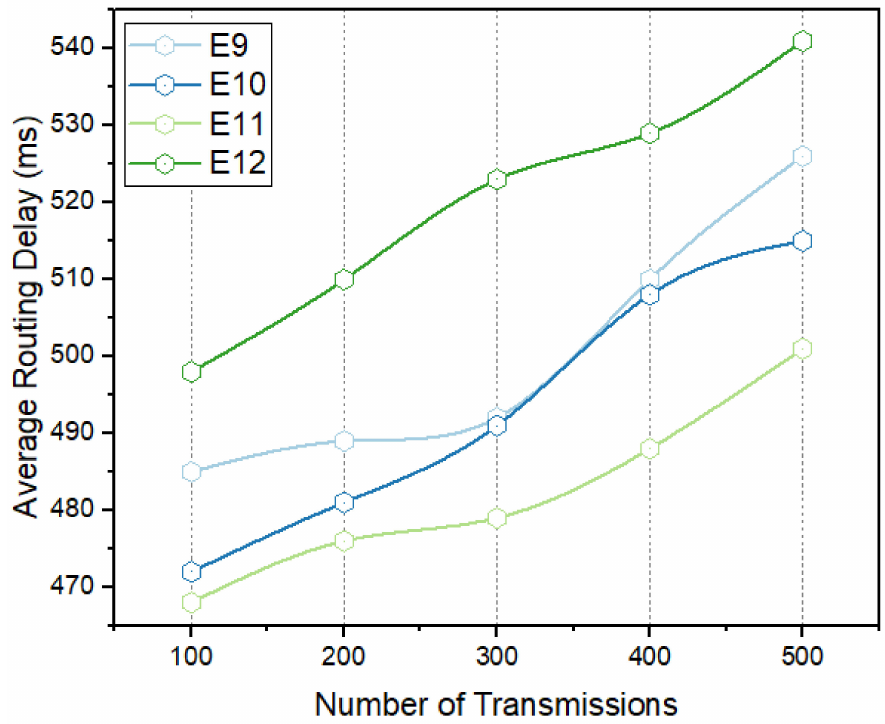
Figure 16. Energy-efficient routing schemes and